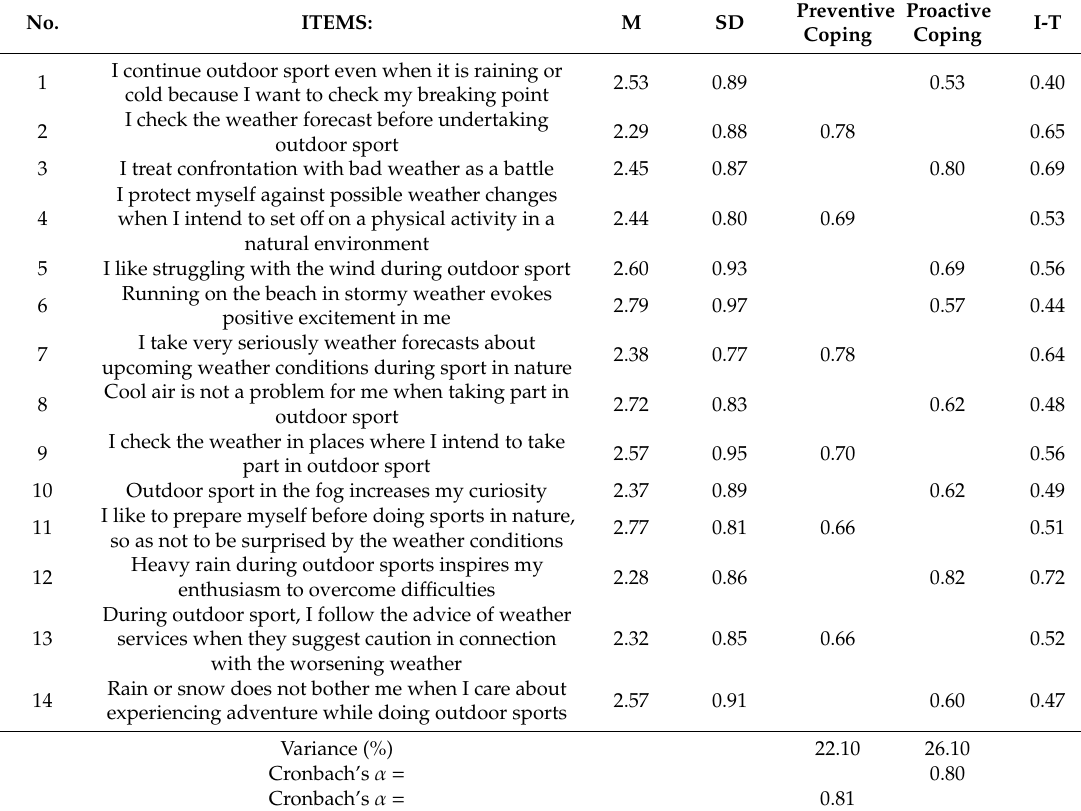
Table 1. Factor loadings for the Preventive and Proactive Coping with Bad Weather in Outdoor Sports Scale.